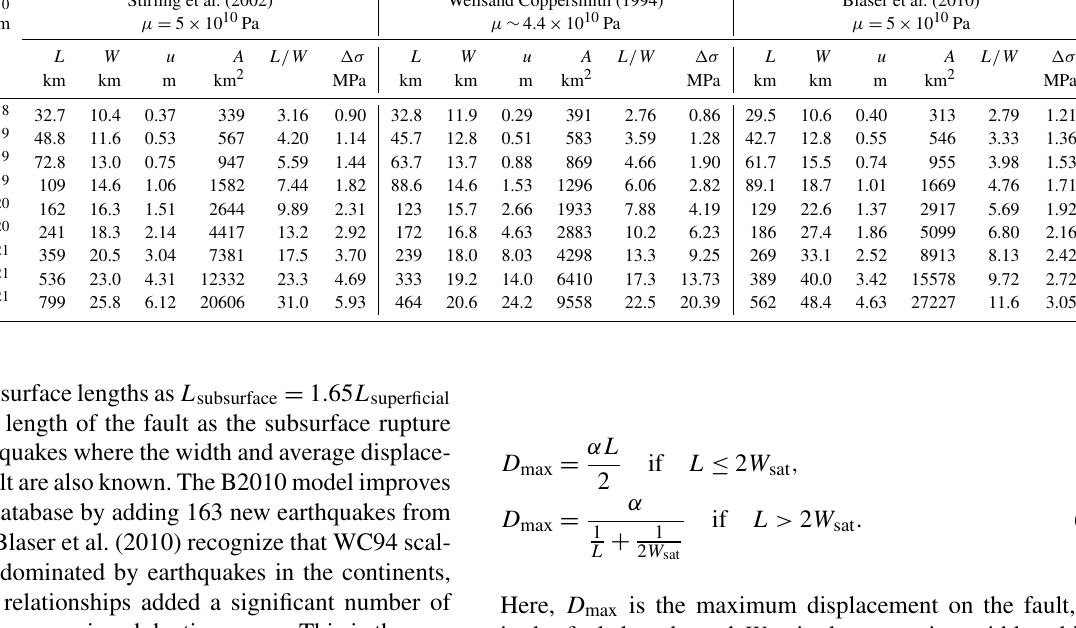
Table 2. Scaling laws for the width, length, and average slip derived from the compilations by Stirling et al. (2002), Wells and Copper- smith (1994), and Blaser et al. (2010). M